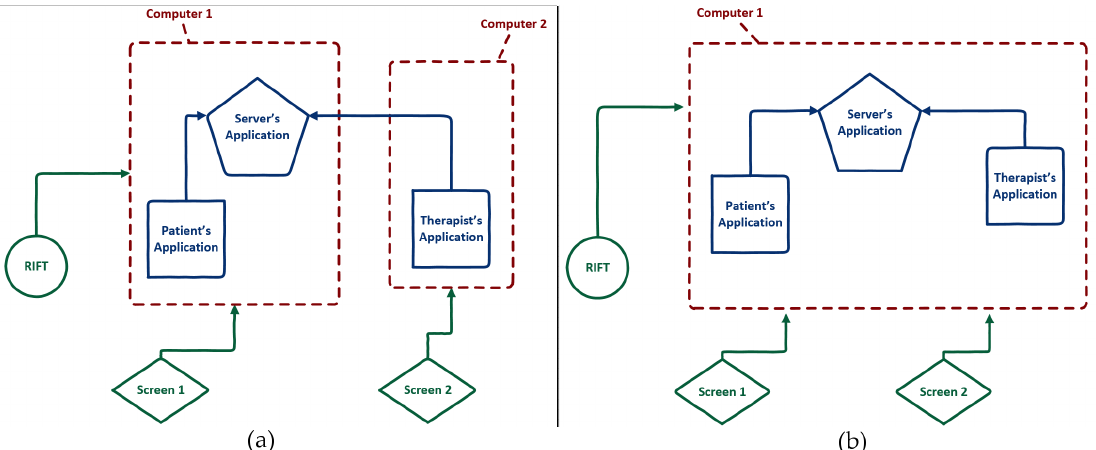
Figure 2. The images represent the two possible setups the system can accept, to be used in the OTs office. They differ in the number of computers (one or two). Configuration 1 ( a ) with two computers. Configuration 2 ( b ) with one computer and two screens.